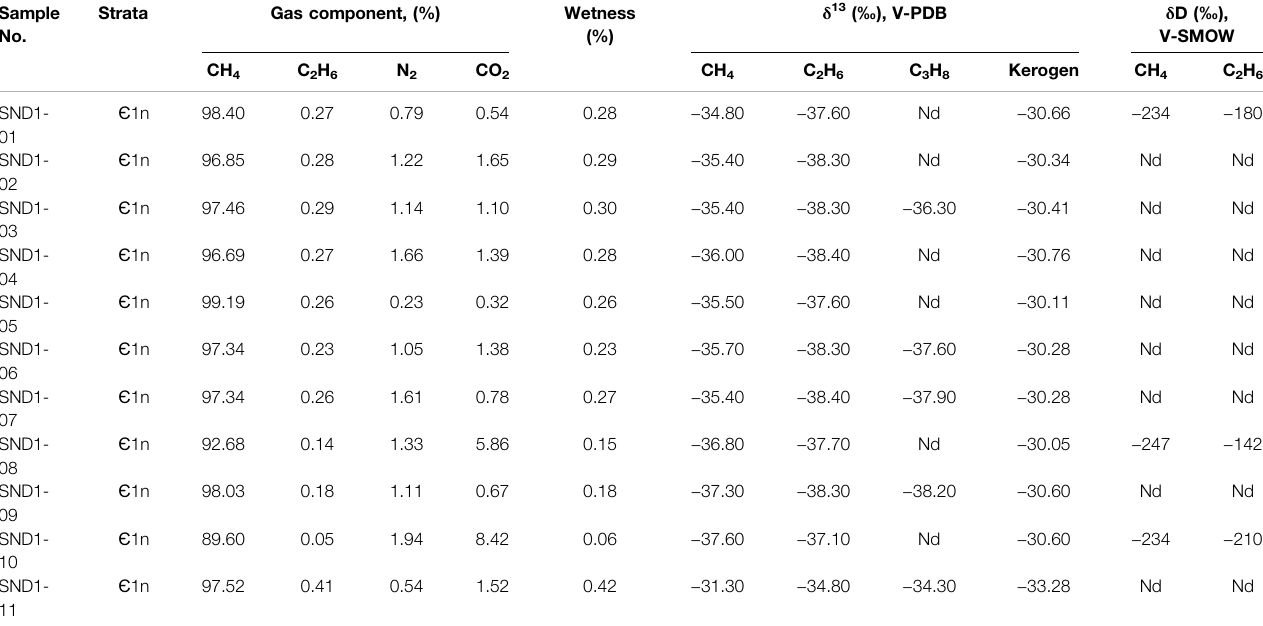
TABLE 2 | Component and isotope properties of the Niutitang Formation shale gas in the study area. Sample No.